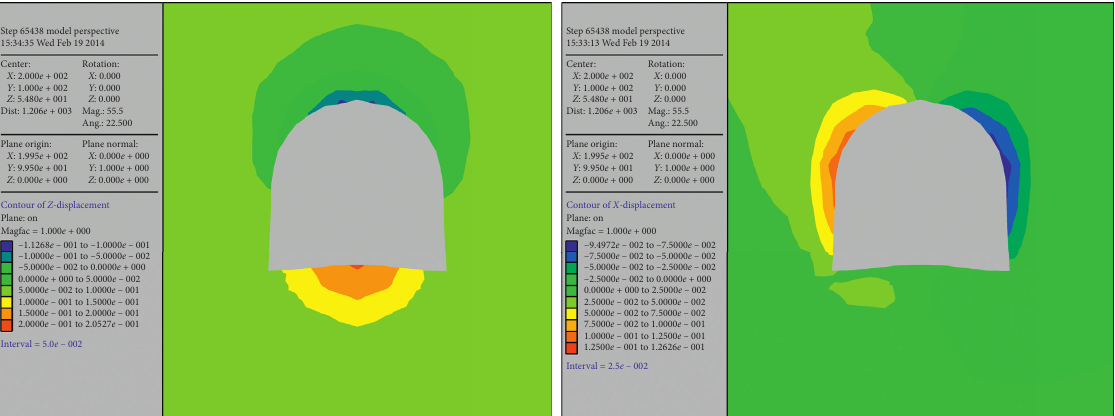
Figure 14: The nephograms of displacement (Scheme